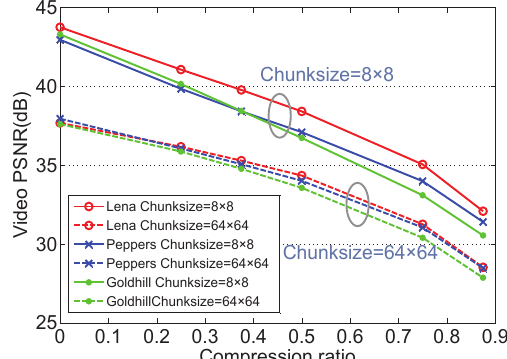
Figure 5: Performance evaluation for different com- pression